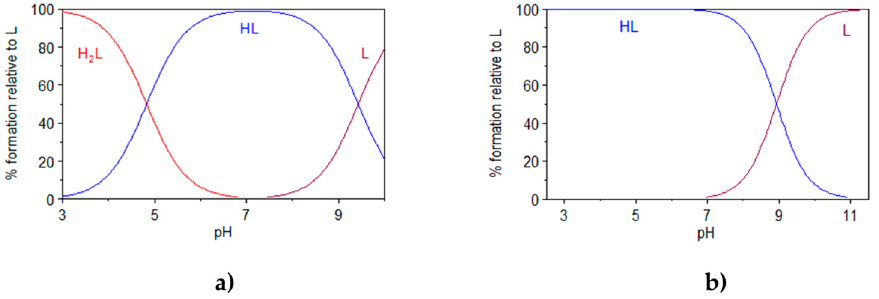
Figure 3. Species distribution curves for compounds ( a ) FA ( C L = 5 × 10 − 4 M) and ( b ) 1d ( C L = 4.0 × 10 − 5 M).